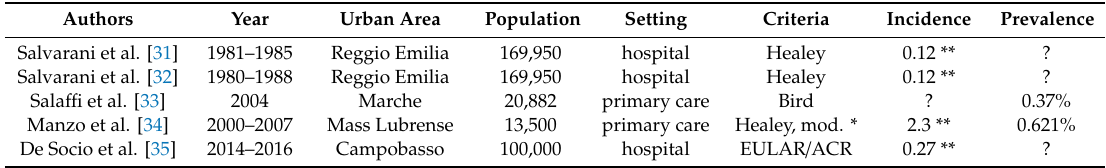
Table 2. Italian epidemiological studies of polymyalgia rheumatica